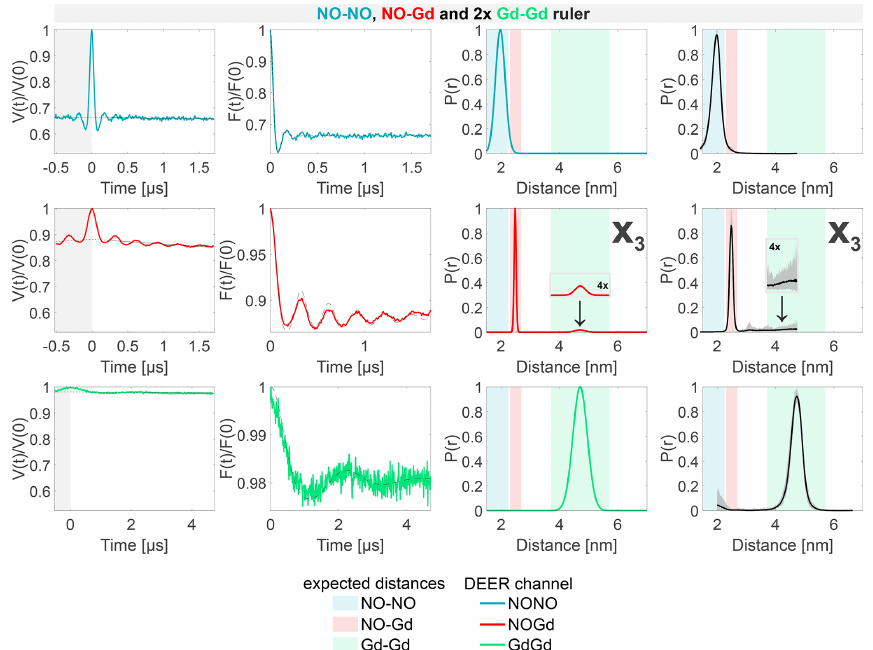
Figure 8. Sample containing the NO–NO, NO–Gd, and Gd–Gd rulers mixed in a 1 : 1 : 2 ratio. The legend is the same as in Fig. 4. X 3 is a Gd–Gd crosstalk signal in the NOGd DEER channel in presence of a NO–Gd